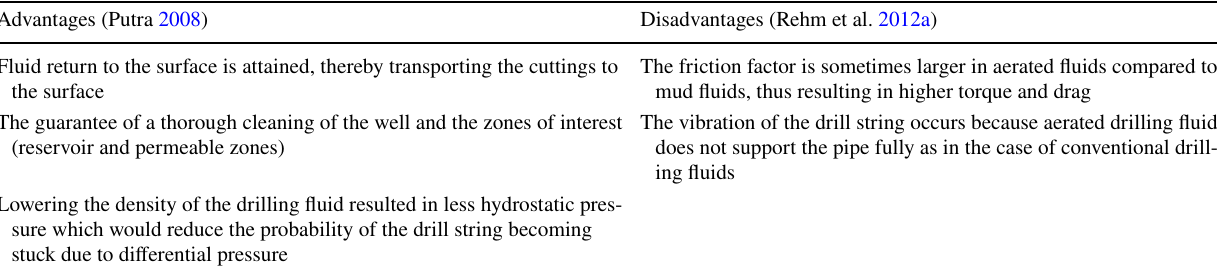
Table 4 Advantages and disadvantages of aerated drilling fluid Advantages (Putra